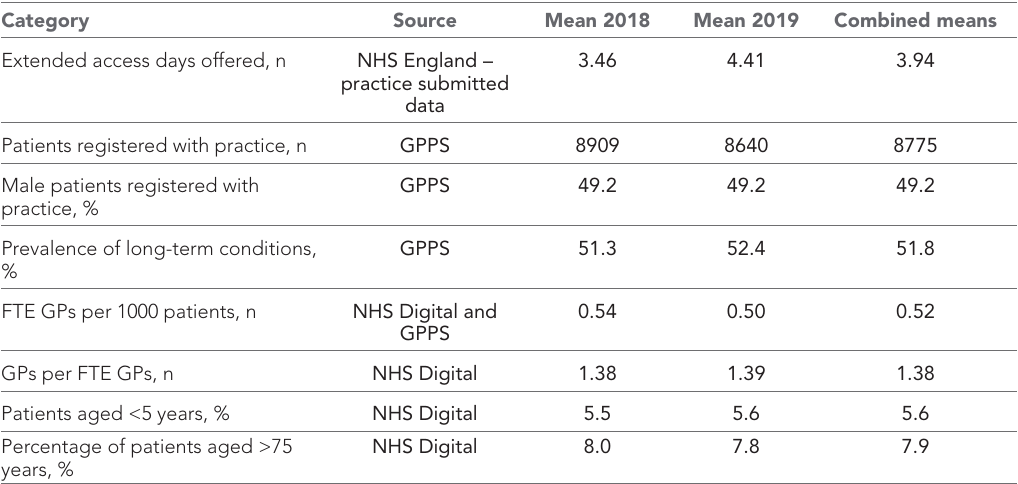
Table 2 Source and average values for explanatory variables used in the analyses